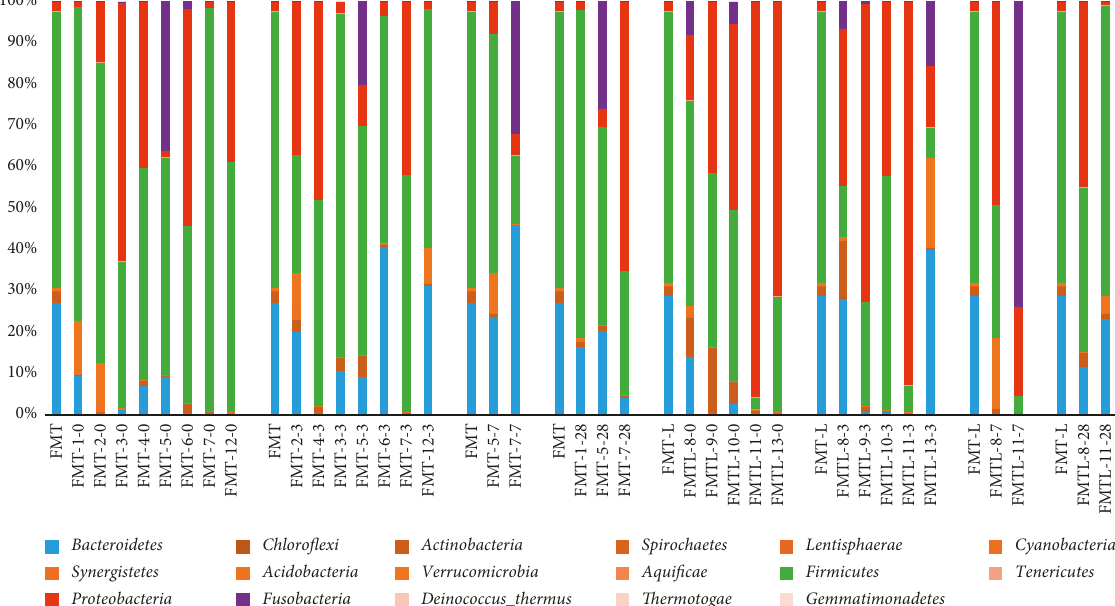
Figure 1: Average bacterial composition at the phylum level. Distribution of bacterial families in the fecal microbiome transplant (FMT) group and the Lactobacillus -FMT (L-FMT) group. The label of each sample (e.g., FMT-5-0) denotes treatment (FMT or L-FMT), the assigned number of each patient, and days on treatment (0 treatment). To facilitate comparison and visualization, the distribution of bacterial families of the donors is presented for the FMTgroup and the L-FMT group.